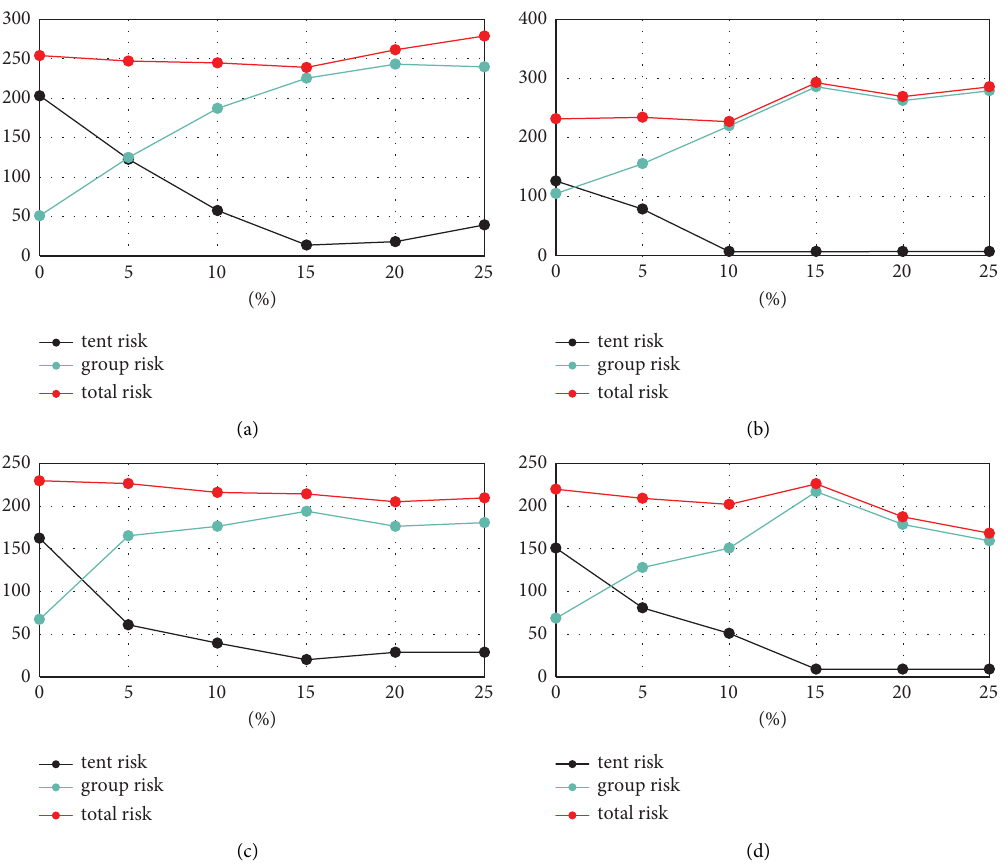
Figure 14: Tentative, grouping and total risk evolution, from 0% to 25% of tolerance factor e . (a) Case study 1. (b) Case study 2. (c) Case study 3. (d) Case study